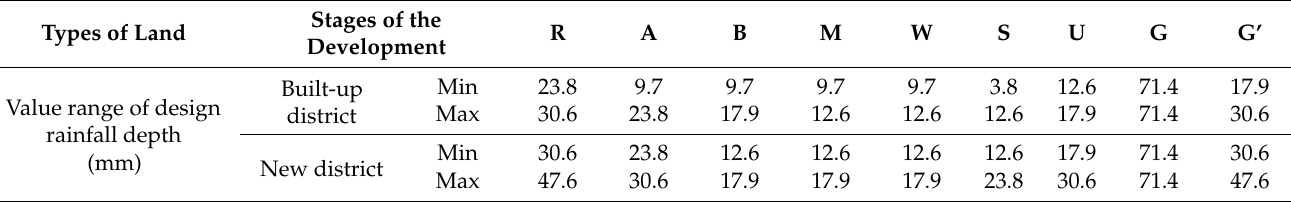
Table 3. The value range of design rainfall depth for every type of land use.